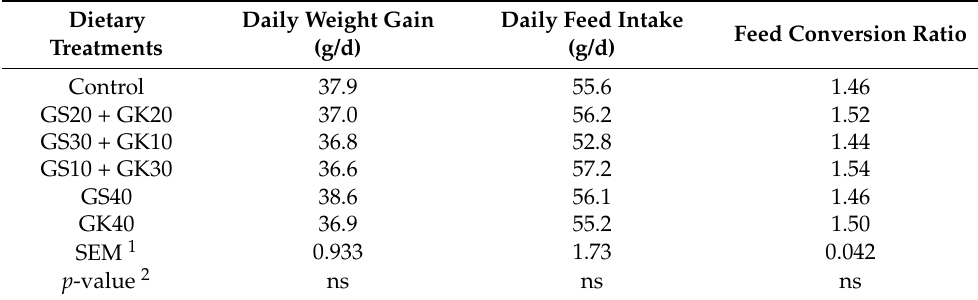
Table 2. Effect of grape seed (GS) and grape skin (GK) meals added at different dietary concentrations (g/kg) on growth performance of broiler chickens (1 to 21 d).